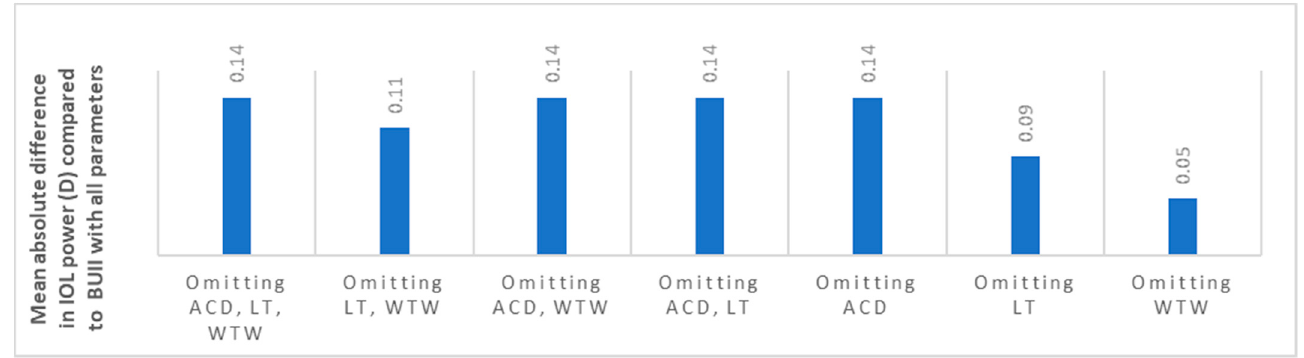
Figure 1. The mean absolute difference in IOL power calculation between partial biometry data and all Barrett Universal II (BUII) parameters in the whole cohort. ACD; anterior chamber depth, D; diopters, IOL; intraocular, LT; lens thickness, WTW; white-to-white.